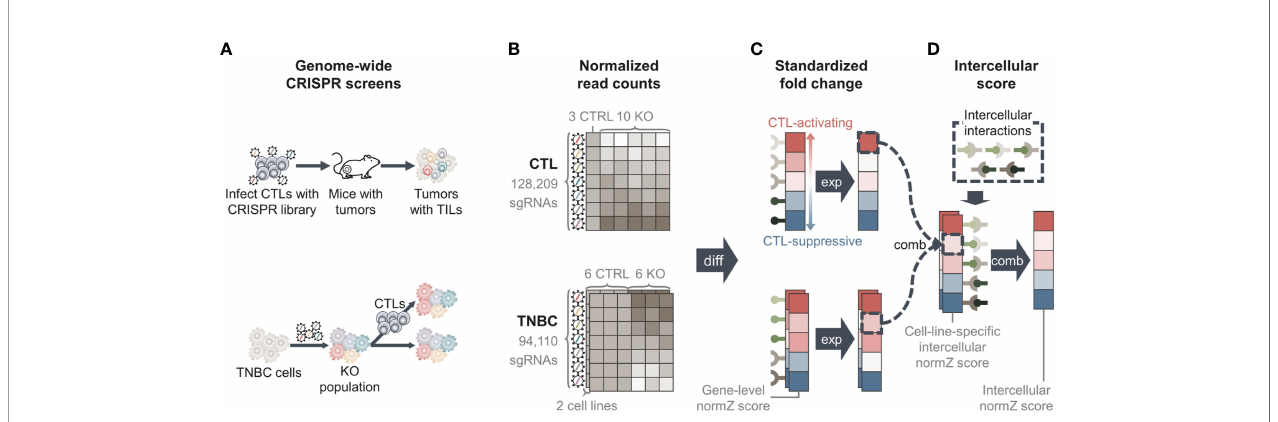
FIGURE 2 | Overview of methods. (A) Data from two genome-wide pooled clustered regularly interspaced short palindromic repeats (CRISPR) screens were used. One CRISPR screen edited cytotoxic T lymphocytes (CTLs) to identify genes whose knockout increased the in fi ltration of CTLs into tumor tissue (upper) (15). The second screen edited two triple-negative breast cancer (TNBC) cell lines to identify genes whose knockout regulates the evasion of TNBC cells from CTL-mediated killing (lower) (8). (B) Genome-wide CRISPR screens yielded normalized read count matrices showing the amount of sgRNAs in each sample. TNBC CRISPR screen data had two matrices, one for each TNBC cell line. (C) We performed differential analysis to calculate fold changes of genes between knockout and control samples, yielding “ Gene- level normZ scores ” . Positive scores were assigned to genes that were more likely to activate CTL function, and negative scores were assigned to genes that were more likely to suppress CTL function. (D) We collected information for intercellular interactions from public databases and calculated the score of each intercellular interaction by ‘ combining ’ gene-level normZ scores of the interactants. Because two TNBC cell lines were used, two ‘ cell-line speci fi c intercellular normZ scores ’ were obtained, one for each TNBC cell line. We combined cell-line-speci fi c intercellular normZ scores to obtain the fi nal intercellular normZ score. TIL, tumor-in fi ltrating lymphocyte; KO, knockout; CTRL, control; diff, differential analysis; exp, expression; comb,